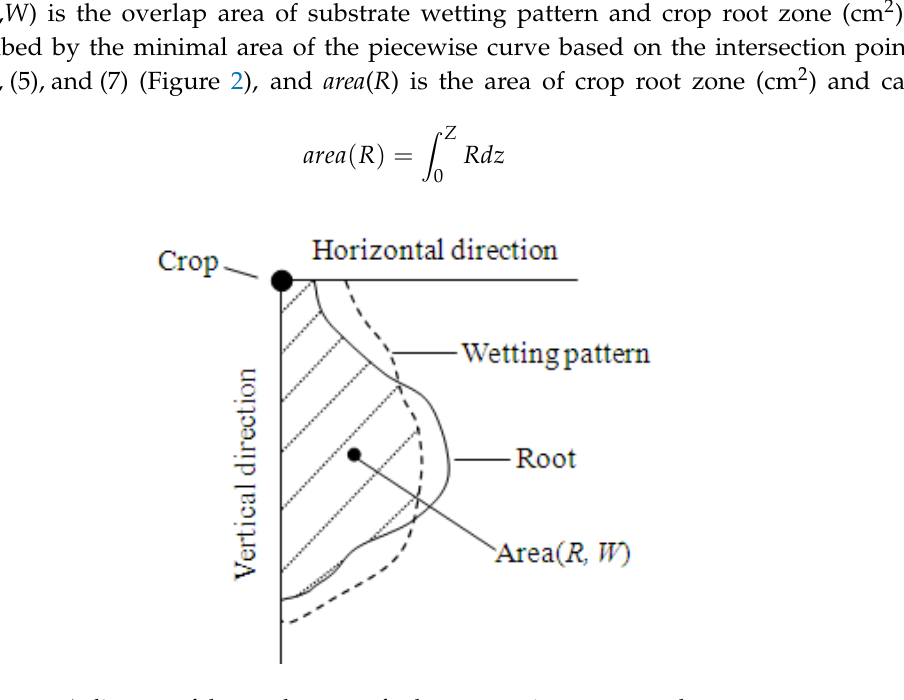
Figure 2. A diagram of the overlap area of substrate wetting pattern and crop root zone.